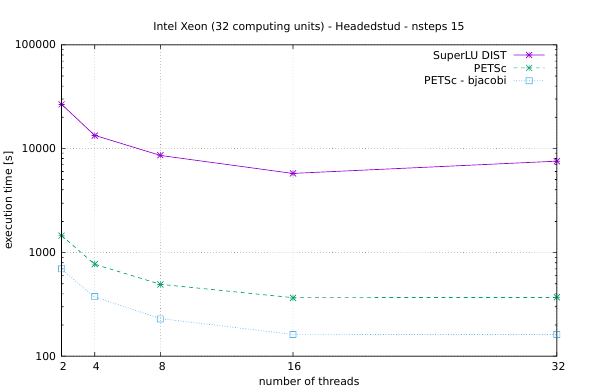
Figure 6. Execution times using the Newton- Raphson method with secant stiffness updated after every iteration.